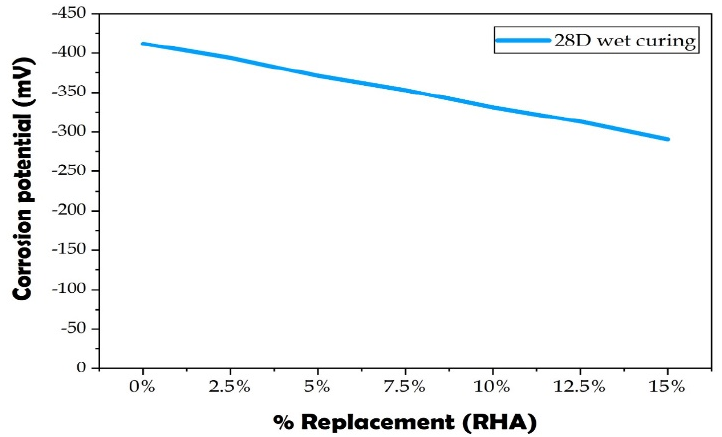
Figure 11. Corrosion potential (mV) of aerated concrete (D—days).